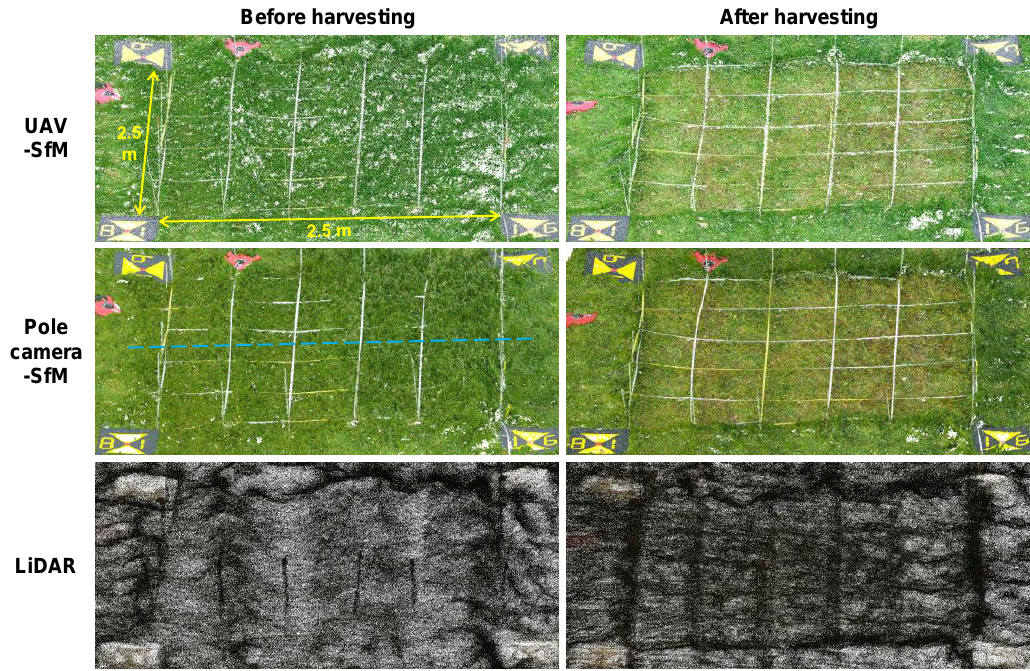
Figure 4. Bird’s-eye view of the point clouds. The blue dashed line represents the survey line of sections presented in Figure 5.